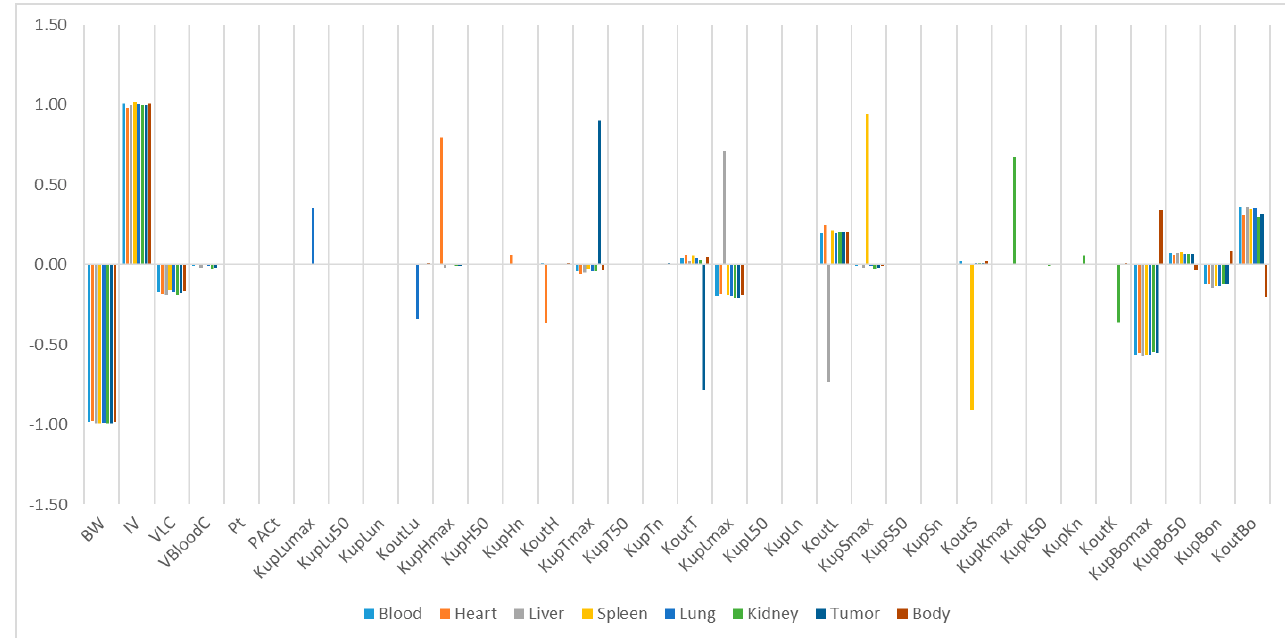
Figure 7. Relative sensitivity analyses for the parameters of mPEG5k-9.09%-80 nm NP concentrations in mouse tissues. Positive values represent PCL-P2 NP concentration increases in the organ when the parameter value increases, while negative values indicate PCL-P2 NP concentration decreases in the organ when the parameter value increases.